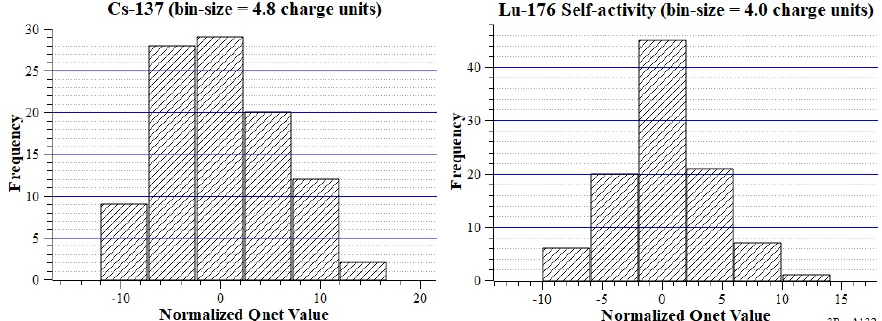
Figure A6. Histograms of average Qnet crystal-pixel values from Cs-137 ( left ) or Lu-176 self-activity ( right ) data. Plots were drawn with 4,8- and 4.0-mm bins, respectively.